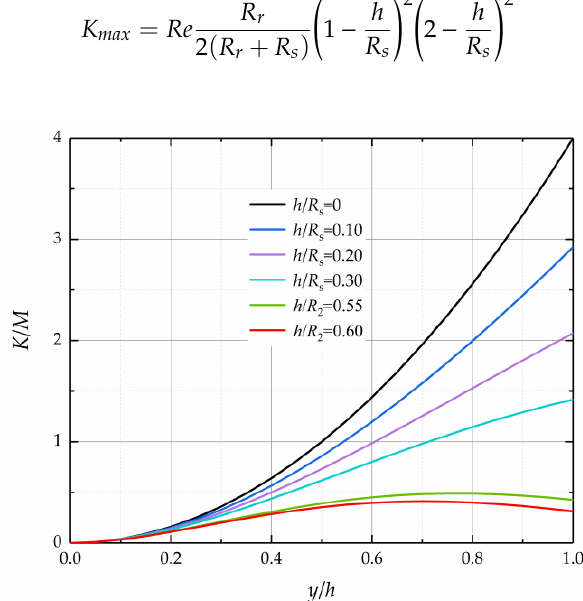
Figure 2. K / M value change trend graph about y / h .